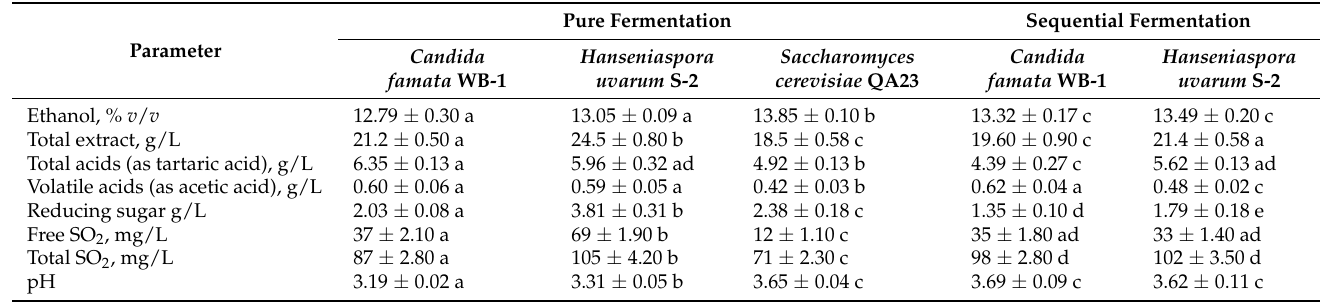
Table 1. Standard quality parameters of Tamjanika wine samples produced in pure and sequential fermentations inoculated with C. famata WB-1, H. uvarum S-2, and S. cerevisiae QA23